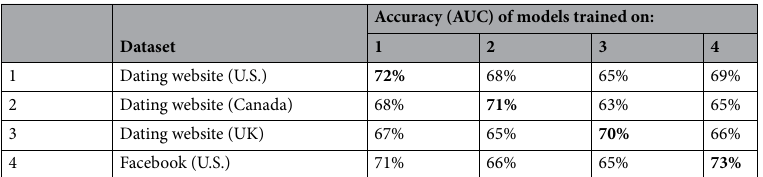
Table 2. Classification accuracy across the subsamples (rows) and models trained on each of the samples (columns). All 95% confidence intervals are below 1% and are thus omitted. Cross-validated in-sample prediction accuracy is presented in